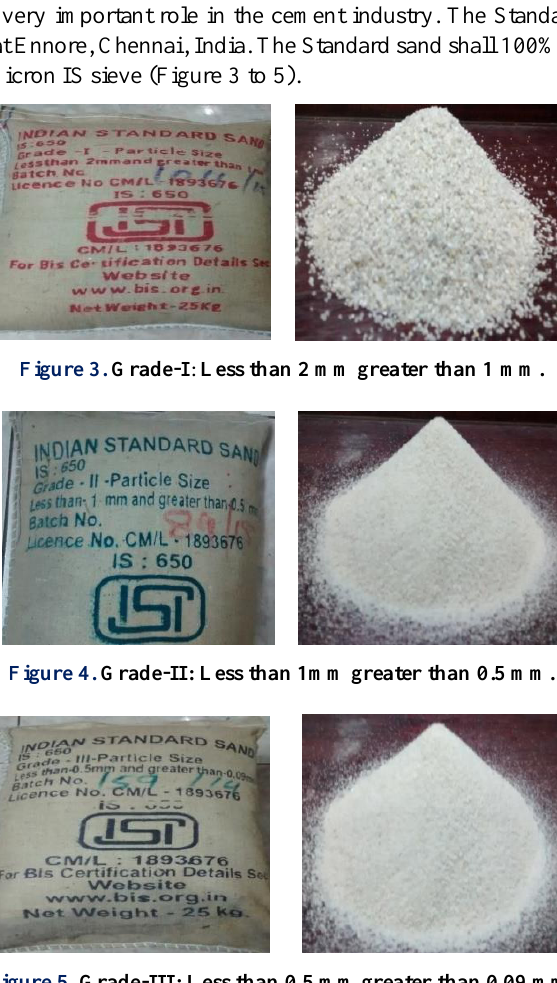
Figure 5. Grade-III: Less than 0.5 mm greater than 0.09